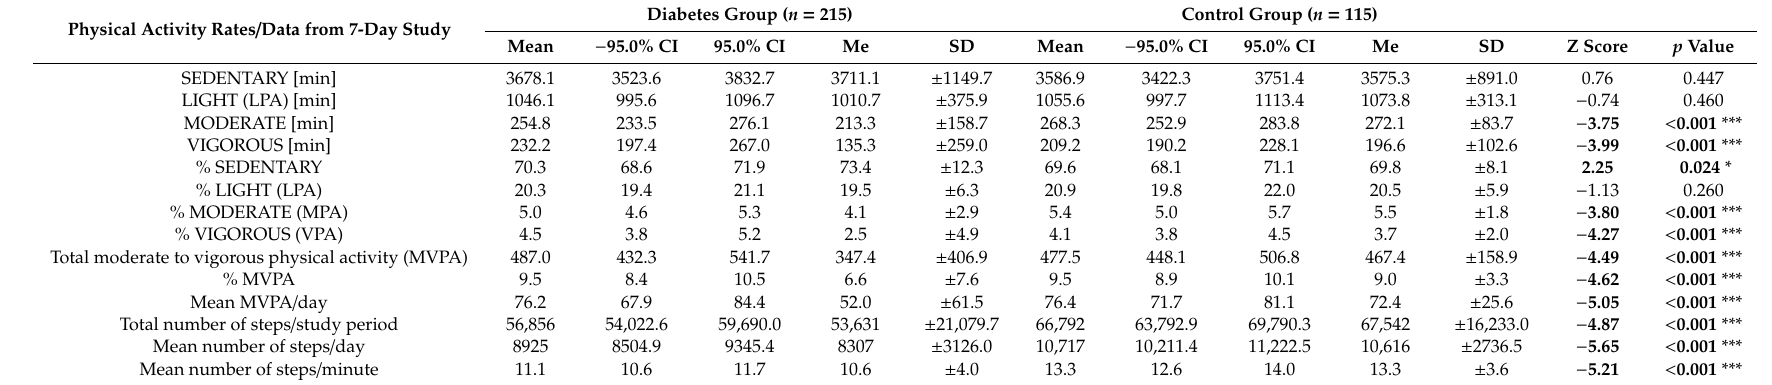
Table 1. Comparison of physical activity rates in the diabetes and the control groups.